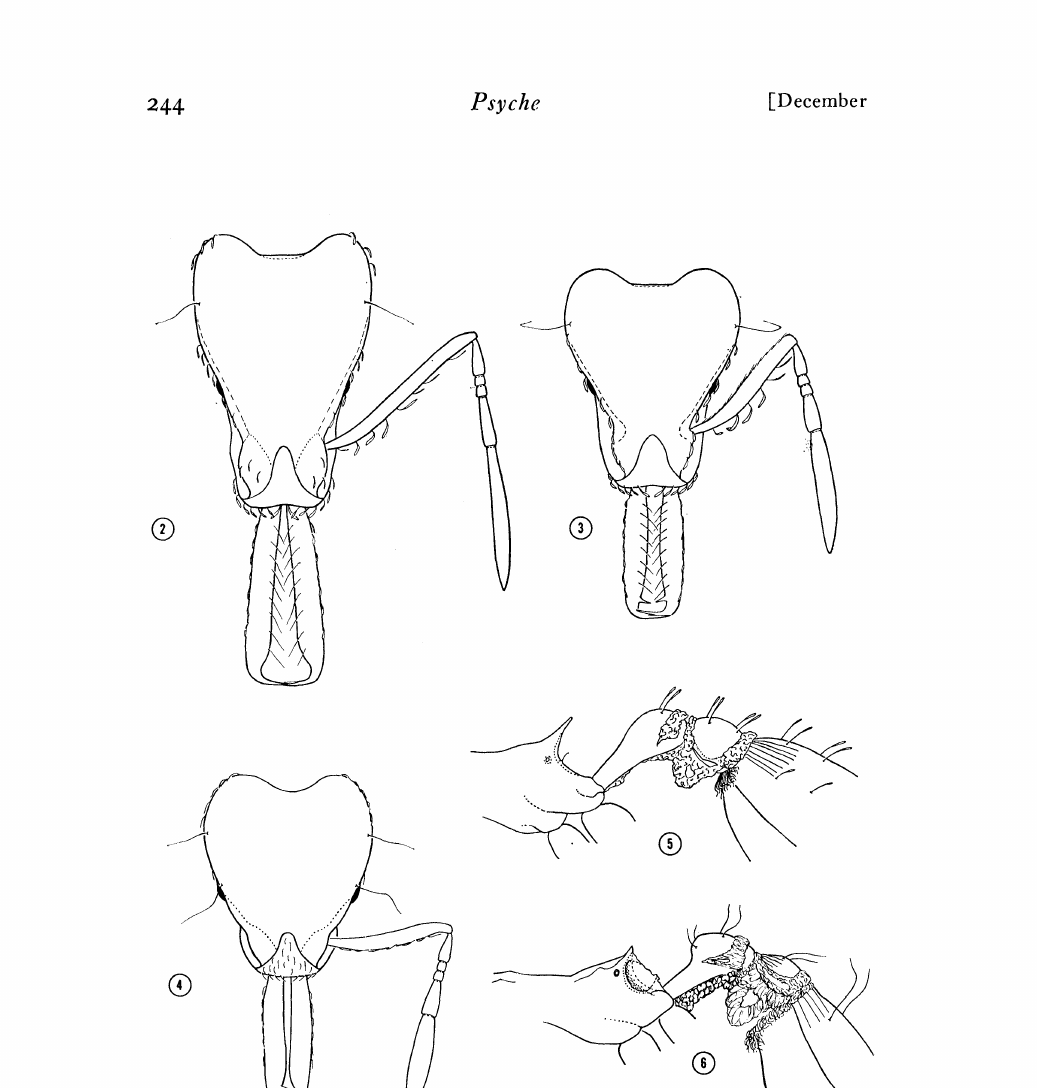
Figures 2-6. Strumiyenys spp., workers. Figure 2, S. lacacoca, paratype, dorsal full-face view of head, showing fringing pilosity only. Figure 3, S. neeermanni, same. Figure. 4, S. lanuginosa, same. Figure 5. S. ludia, Vera.- cruz, side view of posterior alitrunk, nodes and anterior part of gaster. Figure 6, S. lacacoca, paratype, same. Roughly to same